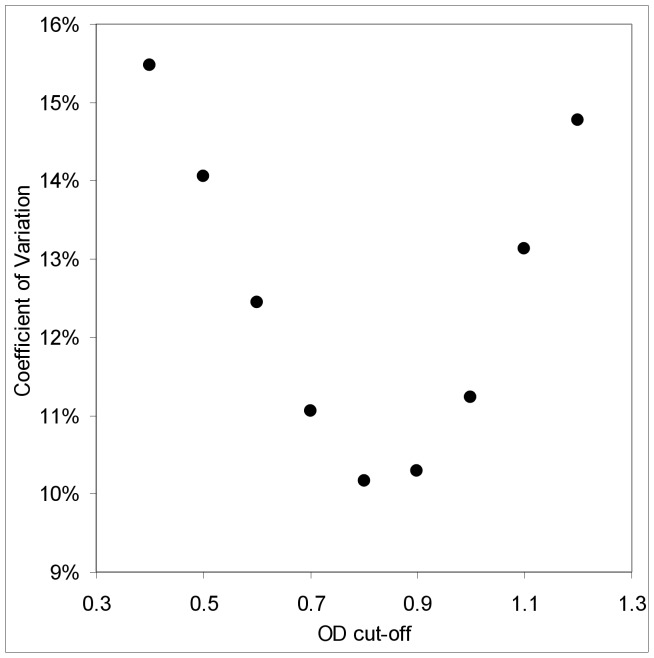
Variability in BED HIV incidence estimates as a function of optical density cut-off (C).The coefficient of variation for BED HIV incidence estimates obtained using the ZVITAMBO baseline data, as a function of the pre-set optical density cut-off (C). Incidence calculated using Equation (1) with values of  estimated by NLMM.